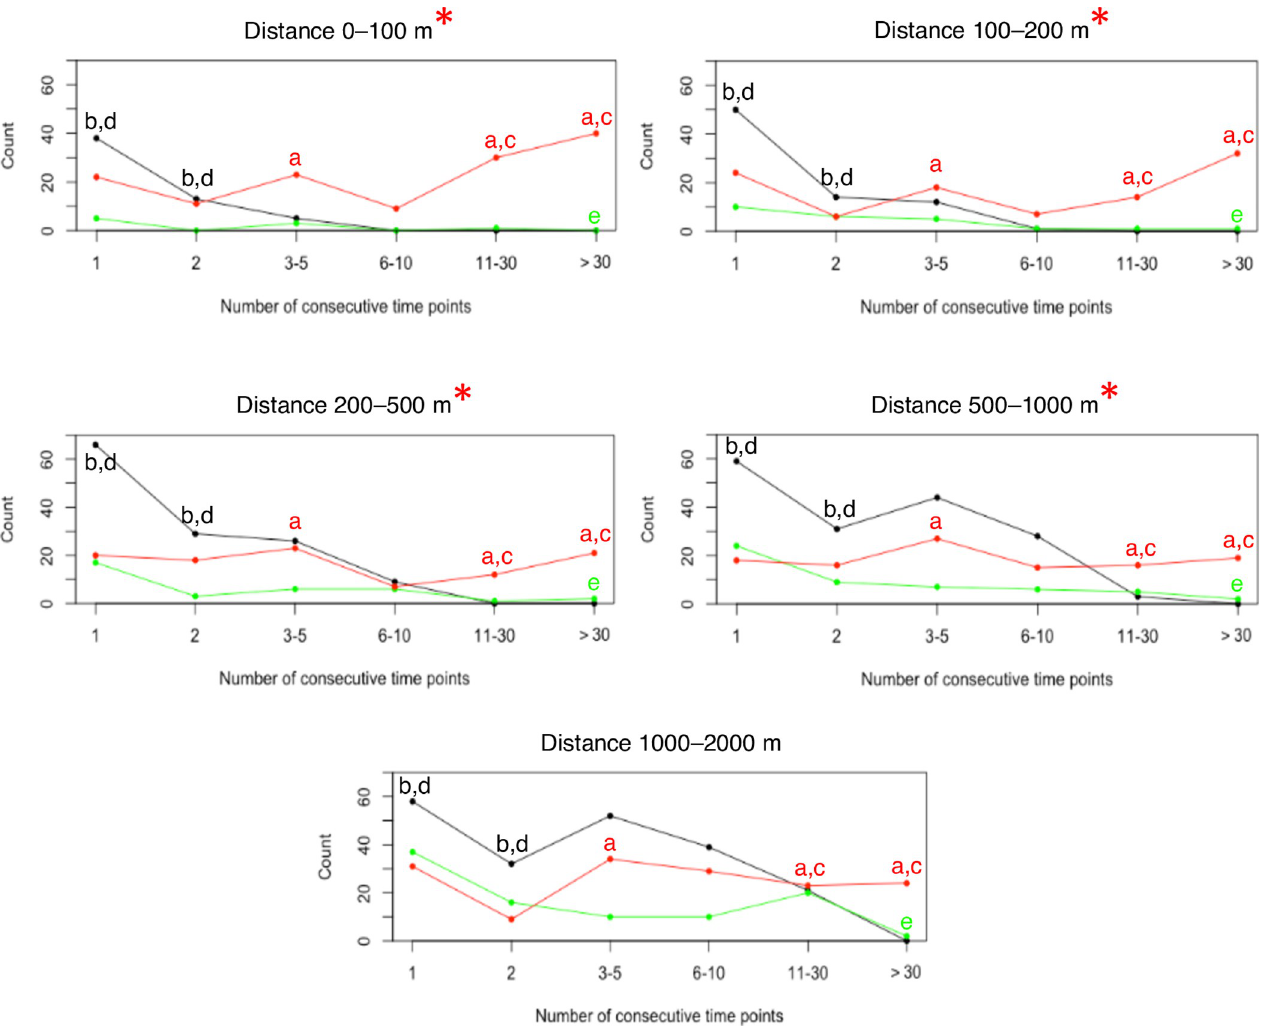
Fig 8. Consecutive time points between lions and spotted hyenas at different distance intervals. Number of consecutive time points (indicating longer time duration) for which pairs of lion-lion (red), hyena-hyena (black), and lion-hyena (green) dyads were at distances of 0-100, > 100-200, > 200-500, > 500-1000, or > 1000-2000 m. Red asterisks at distance intervals indicate where the lion-lion dyad had significantly more consecutive time points contrasted to lion-hyena dyads. Letters indicate significance for the dyad at that time duration: lion-lion vs lion-hyena (a), hyena-hyena vs lion-hyena (b), lion-lion vs hyena-hyena (c), hyena-hyena vs lion-lion (d), lion-hyena vs hyena-hyena (e). Number of dyads: 9 lion-lion dyads, 4 hyena-hyena dyads, and 10 lion-hyena dyads. Statistical results are presented in S13 Table.